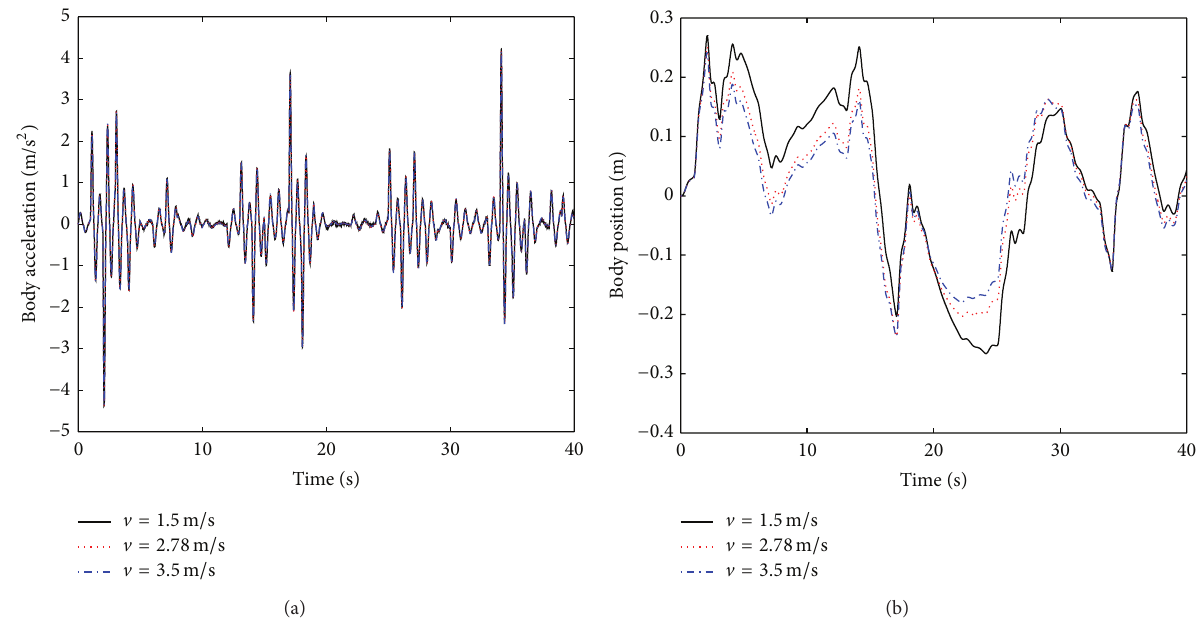
Figure 8: Acceleration and displacement of the sprung mass with different vehicle